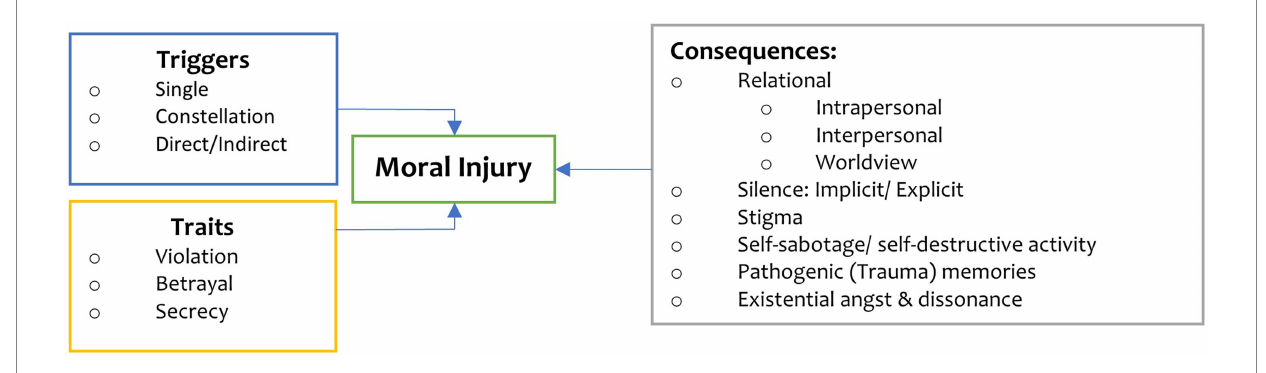
FIGURE 1 Key aspects of moral injury and